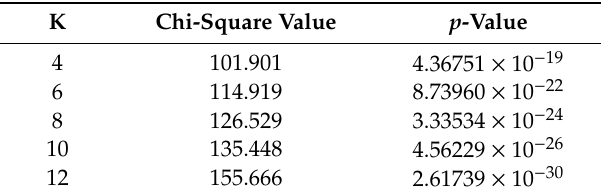
Table 10. The chi-square value and p -value (Friedman test) for the experimental results of the MCE method.